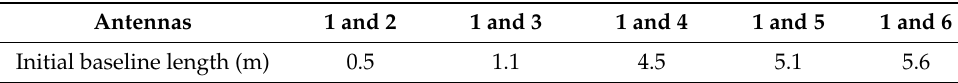
Table 1. Initial baseline length between antenna 1 and other antennas. Antennas 1 and 2 1 and 3 Initial baseline length (m)